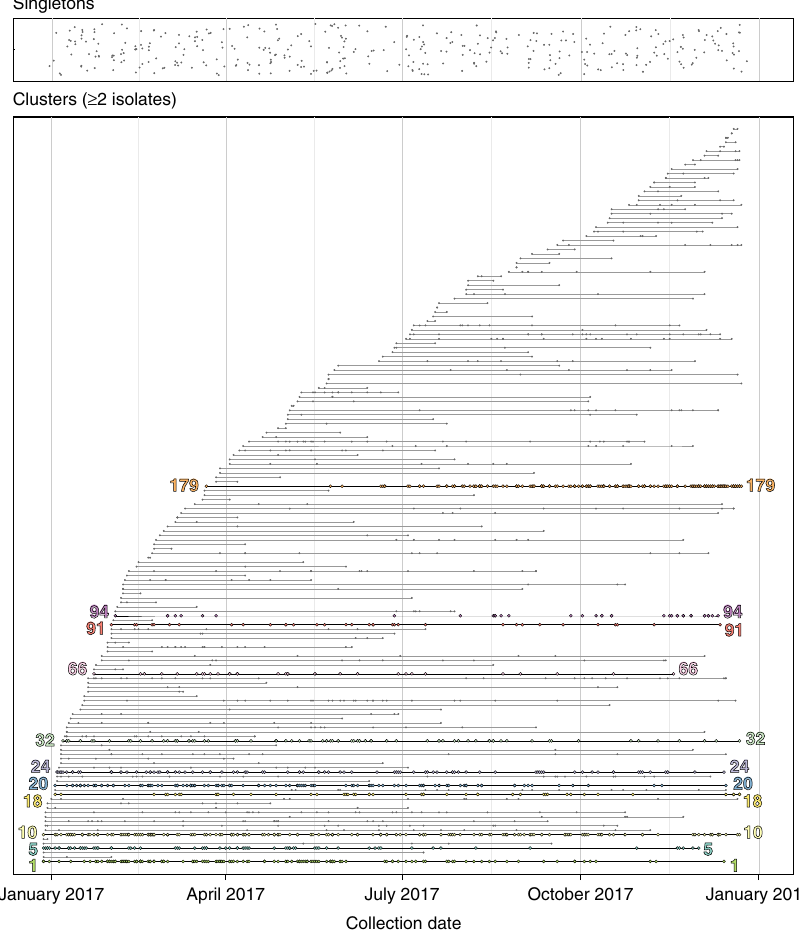
Fig. 1 Clusters of Neisseria gonorrhoeae isolates in Victoria, Australia, 2017. Isolates are classi fi ed according to whether they are single isolates (top box) or in a cluster of ≥ 2 isolates (bottom box). Each cluster contains all individuals with isolates related by ≤ 10 single nucleotide polymorphisms using hierarchical single-linkage clustering. Major clusters (comprising >30 individuals) are highlighted on the timeline in the bottom box. Each dot represents an isolate from an individual, and each cluster is plotted along a horizontal line, representing date of sample